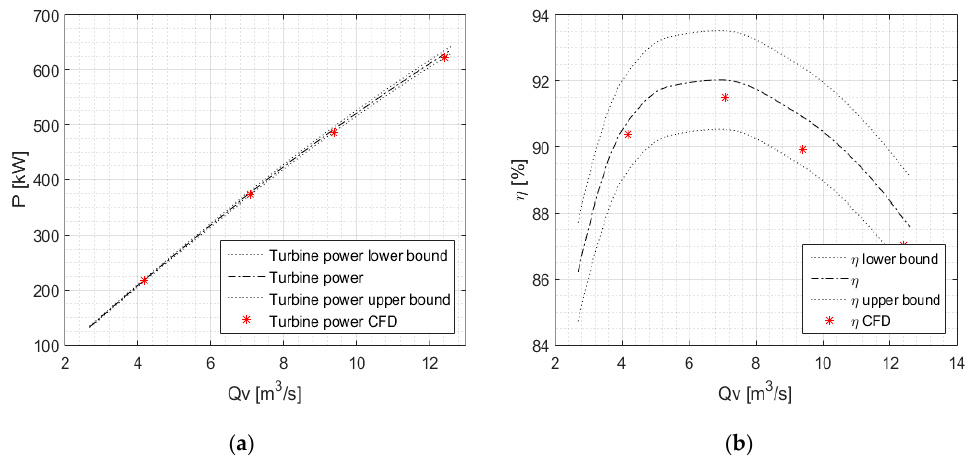
Figure 4. Validation results: ( a ) power data; ( b ) efficiency.